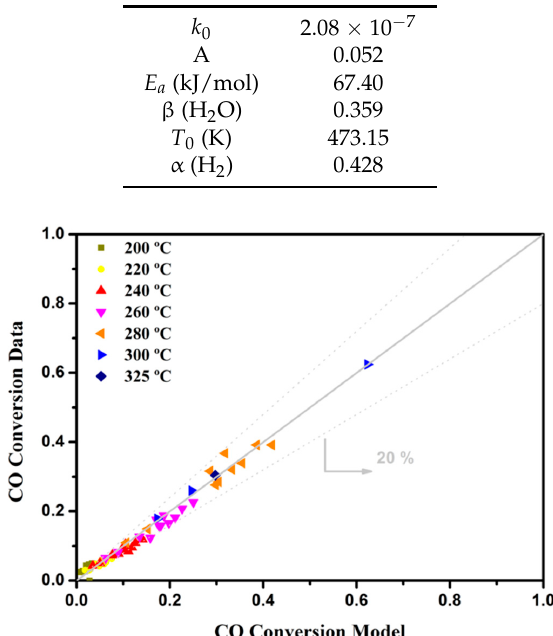
Table 4. Calculated kinetic parameters for the proposed reaction rate expression (Equation (15)) for WGS reaction on structured PtCeAl + ZrEuMo sample.